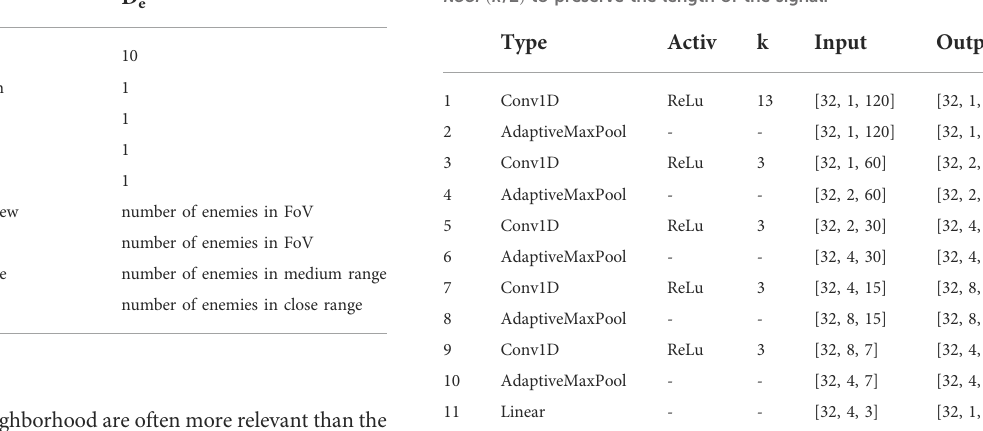
TABLE 1 Arousing game events and their arousal value D  . TABLE 2 Machine learning model architecture. For the convolution layers,thekernelsizeisindicatedincolumnk, stride =1, padding (cid:2) floor ( k /2 ) to preserve the length of the